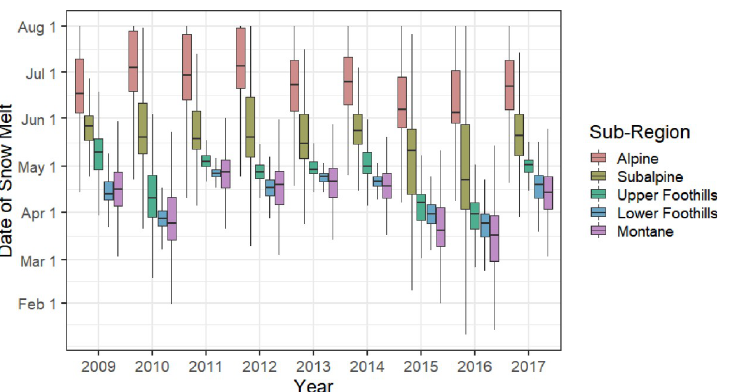
Fig 3. The date of snow melt annually by natural sub-region classification.